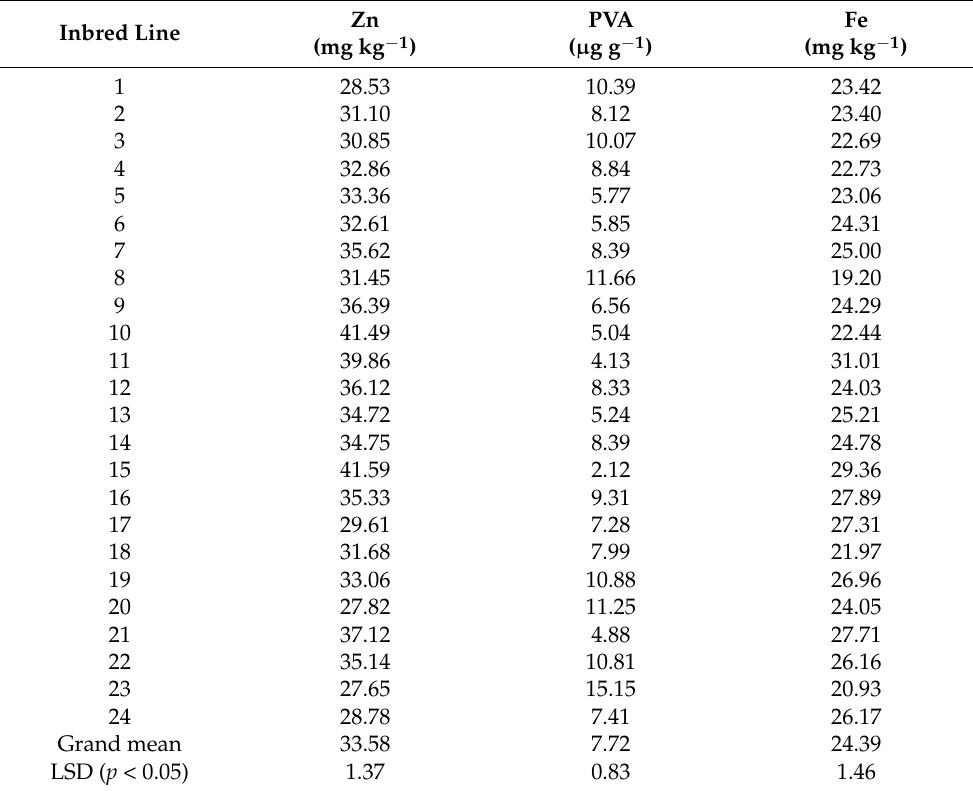
Table 1. Mean micronutrients concentrations of 24 parental inbred lines across environments.